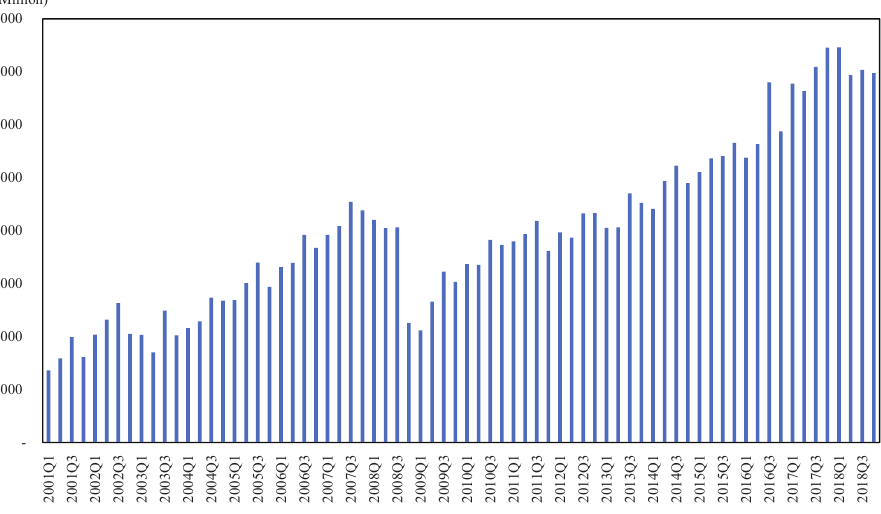
Figure 1. International tourist expenditure and global events in Korea